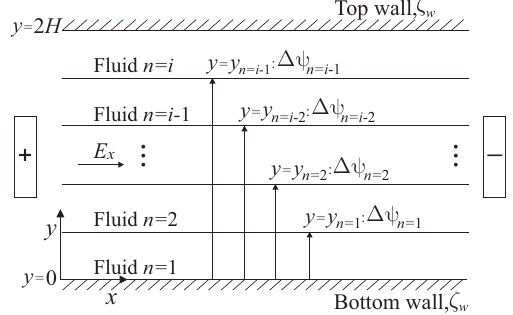
Figure 1. Sketch of electroosmotic flow of multi-layer immiscible fluids in a slit